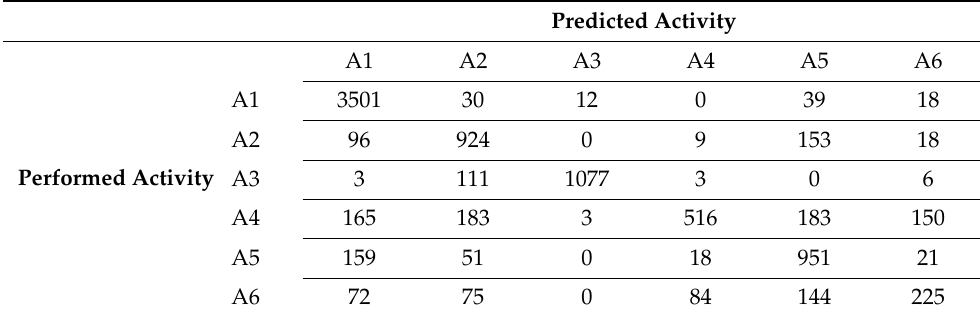
Table 12. The confusion matrix obtained for the fourth evaluation scenario.